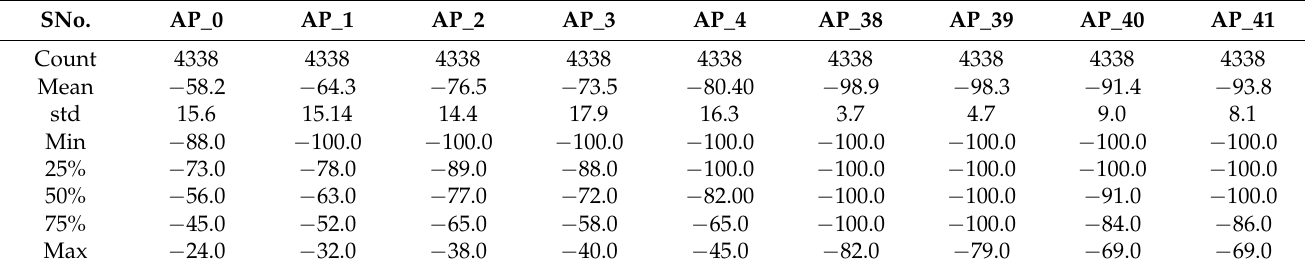
Table 5. The distribution and descriptive measures of the Online RSS measures.